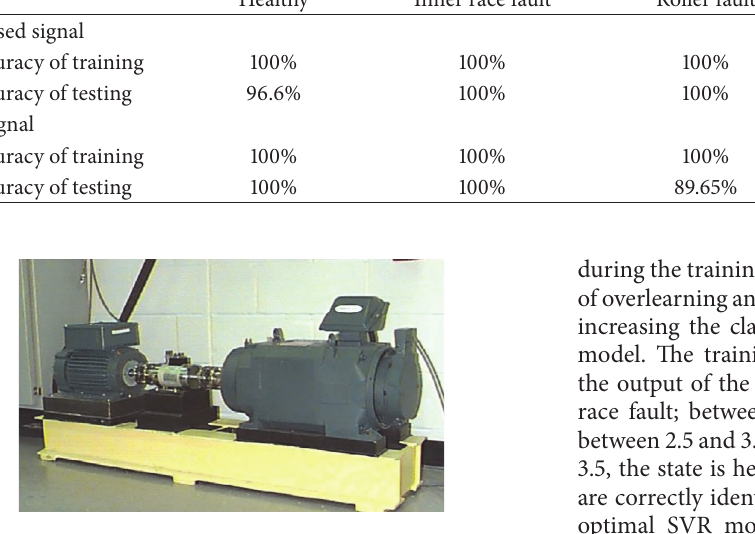
Figure 4: Experimental